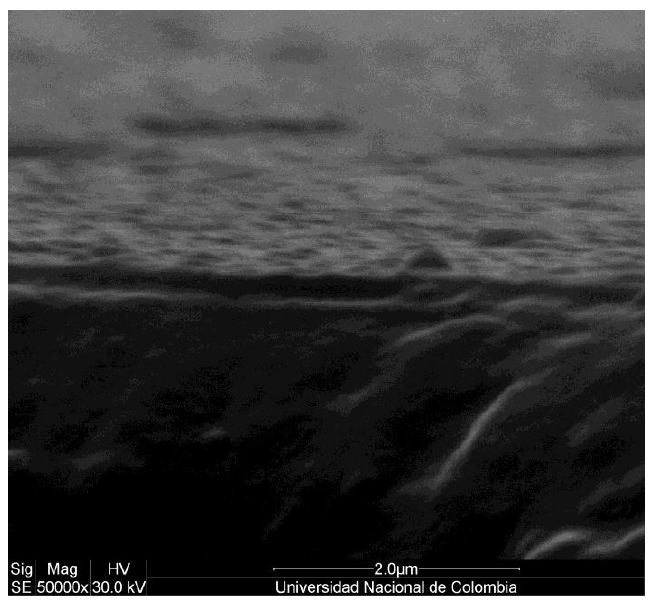
Figure 7. SEM micrograph of the transverse section of